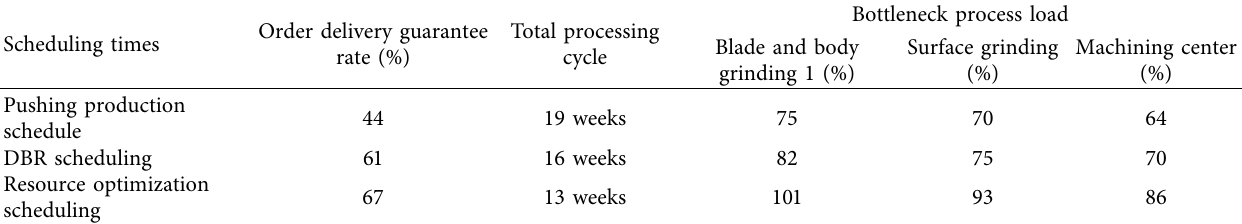
Table 1: Comparison of the effectiveness of three production planning